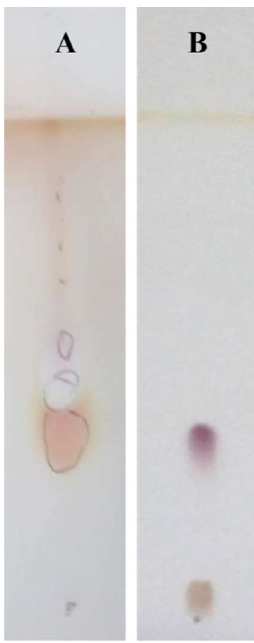
Figure 3. Thin layer chromatography analysis of the unpurified biosurfactant compound ( A ) compared to the purified biosurfactant ( B ) produced by R . opacus R7 developed with CH3Cl:Me(OH):H 2 O [40:51:9] detected with ninhydrin.